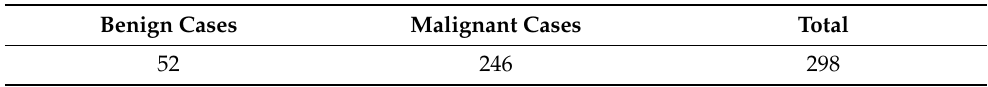
Table 2. Details of the TDID